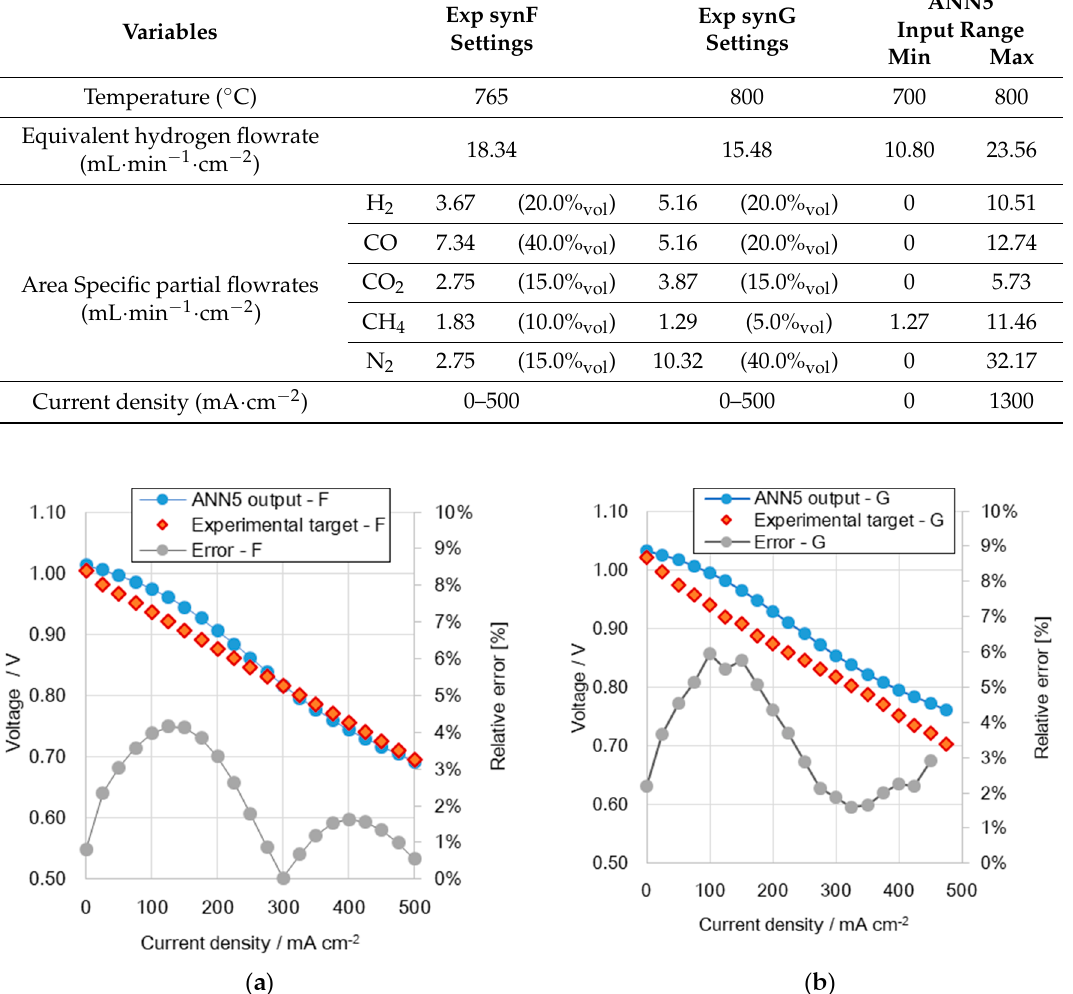
Figure 6. ANN5 application: comparison of simulated and experimental polarization curves ( a ) under Exp synF and ( b ) Exp synG operating conditions.